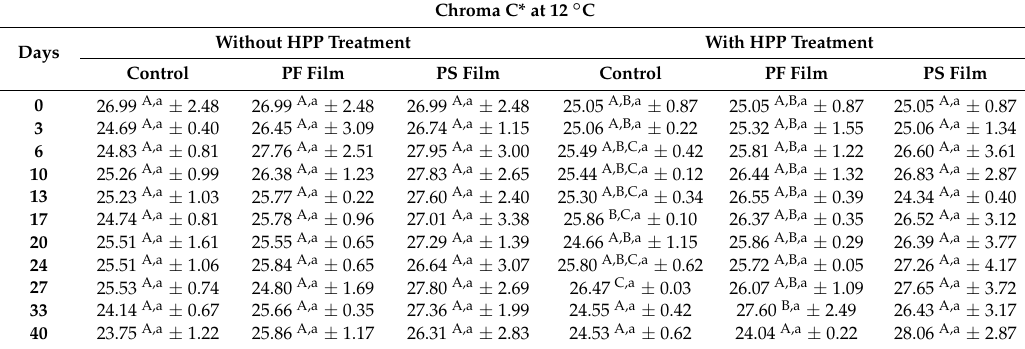
Table 6. Changes in C* values for ham slices treated or not with HPP, during storage at 12 ◦ C. Chroma C* at 12 ◦